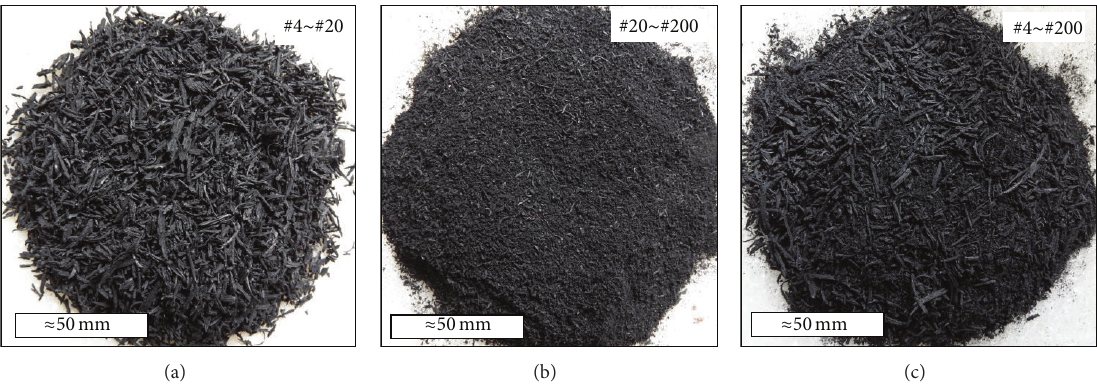
Figure 3: Appearance of crumb rubber particles: (a) #4 ∼ #20; (b) #20 ∼ #200; (c) #4 ∼ #200.